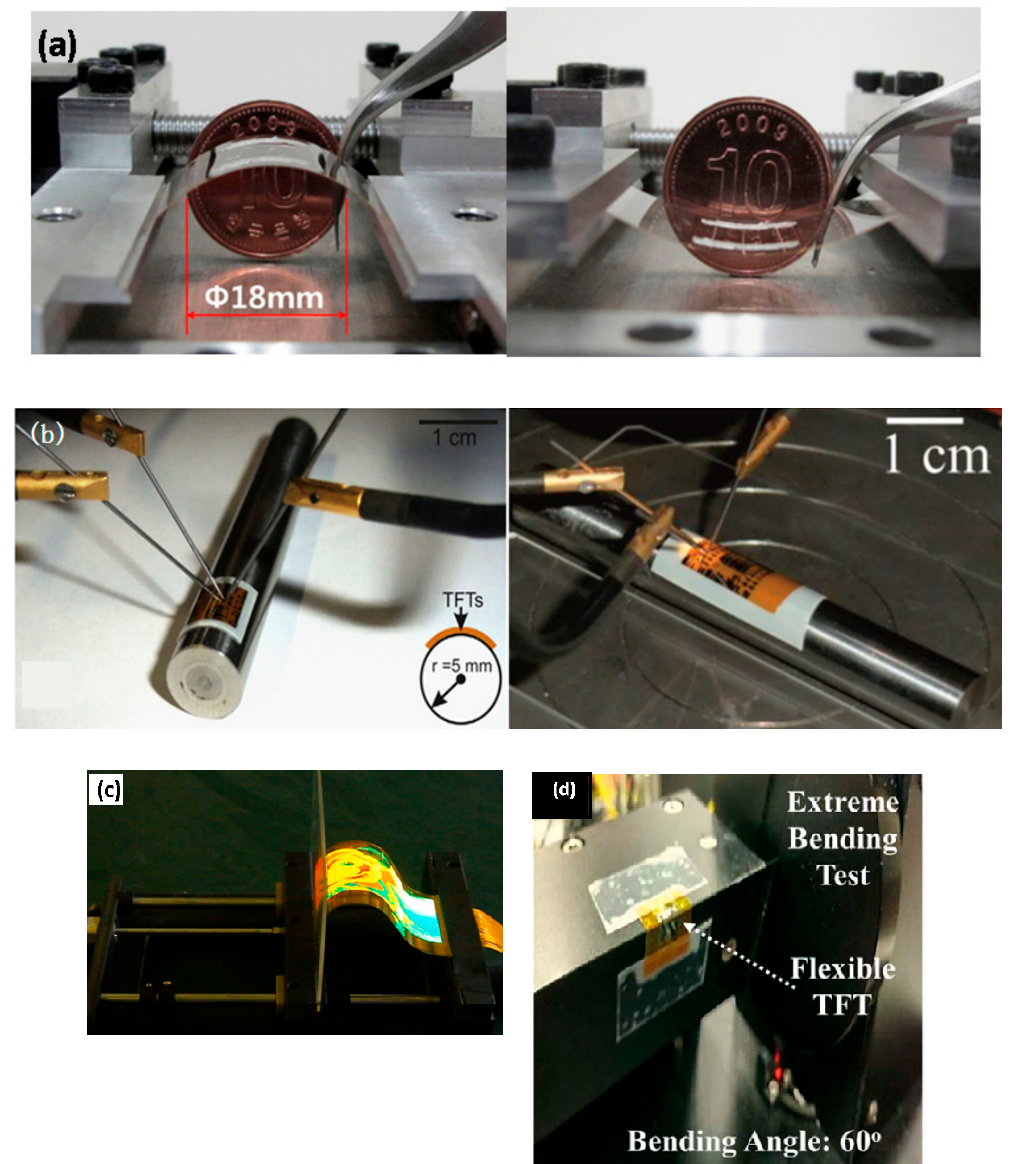
Figure 11. Bending test platforms ( a ) Substrate between two moving metal splints [173]. ( b ) Substrate wrapped around the rigid cylindrical rods [158]. ( c ) Custom-built bending testers [162]. ( d ) Extreme bending test